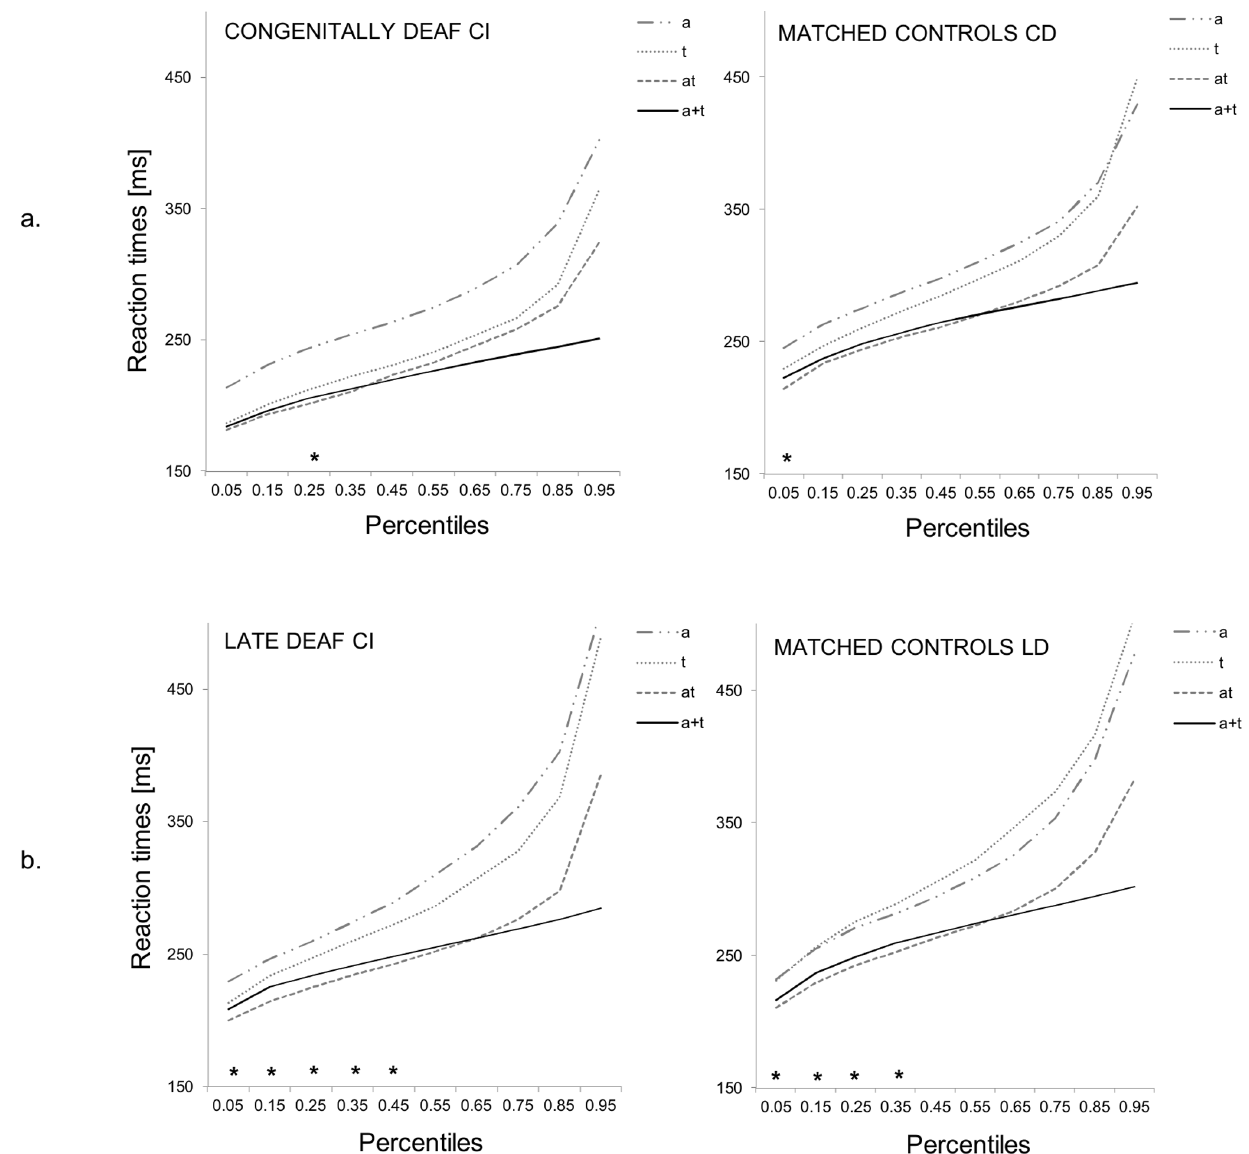
Figure 5. Multisensory facilitation indexed by violation of the race model. Cumulative distribution functions for response time to unisensory auditory and tactile stimuli and crossmodal stimuli for a. congenital deaf CI recipients and their age-matched controls and b. late deaf CI recipients and their age-matched controls. The filled black line indicates the summed proportions to unimodal stimuli ( a + t , race model), at the violation of the race model, and a and t the responses to single auditory and tactile stimuli,